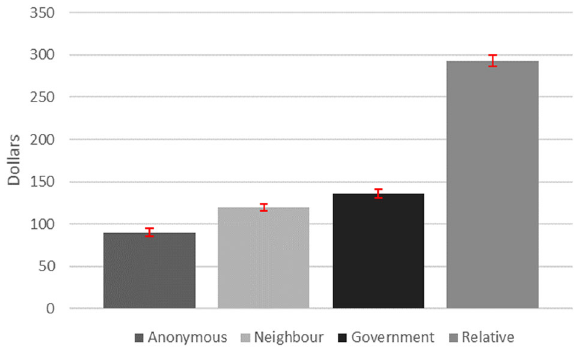
Fig. 1 Mean donations by receiver. Average donations in the four dictator game types are given, along with mean standard error bars.